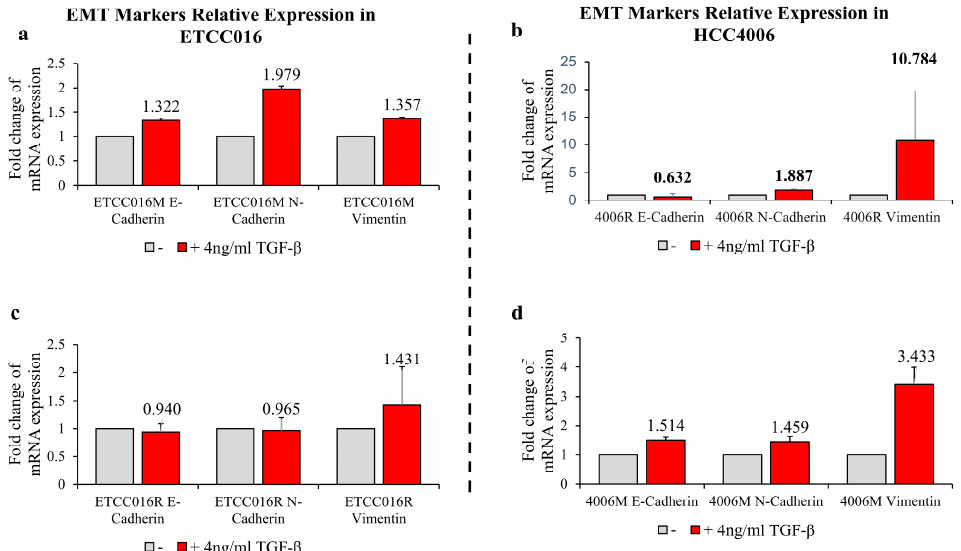
Figure 4. RT-qPCR results of EMT markers: E-cadherin, N-cadherin and vimentin. RT-qPCR experi- ments were performed after 36 h exposure with/without 4 ng/mL TGF– β . ( a , c ) Mock and resistant groups of ETCC016 cell line were induced EMT. ( b , d ) Resistant and mock groups of HCC4006 cell lines represent greater increase in vimentin expression, 10-fold increase in the resistant group and 3-fold increase in the mock